Question: Draft a figure caption describing what is shown.
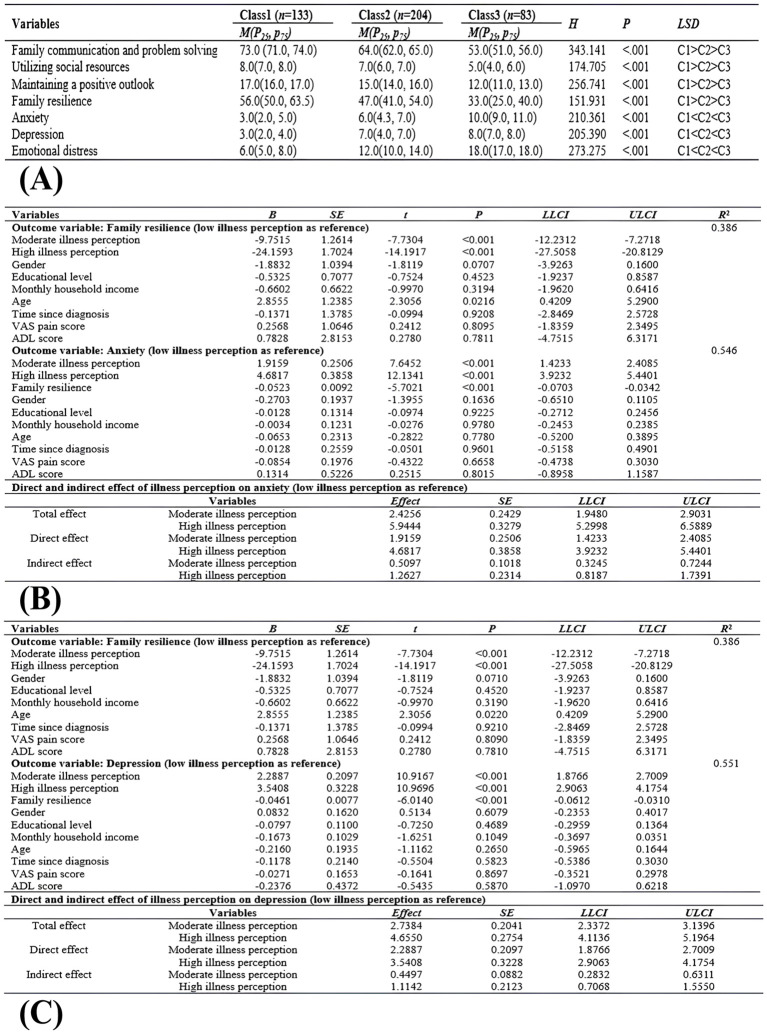
Answer: (A) Differences in family resilience and emotional distress scores across illness perception profiles. (B) The mediating role of family resilience in anxiety. (C) The mediating role of family resilience in depression.